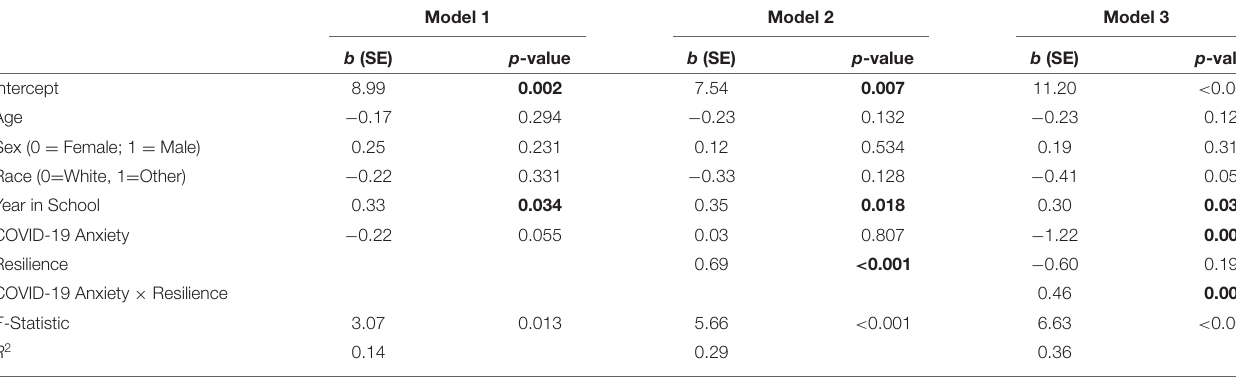
TABLE 2 | Multiple regression models estimating associations between COVID anxiety, resilience, and flourishing.